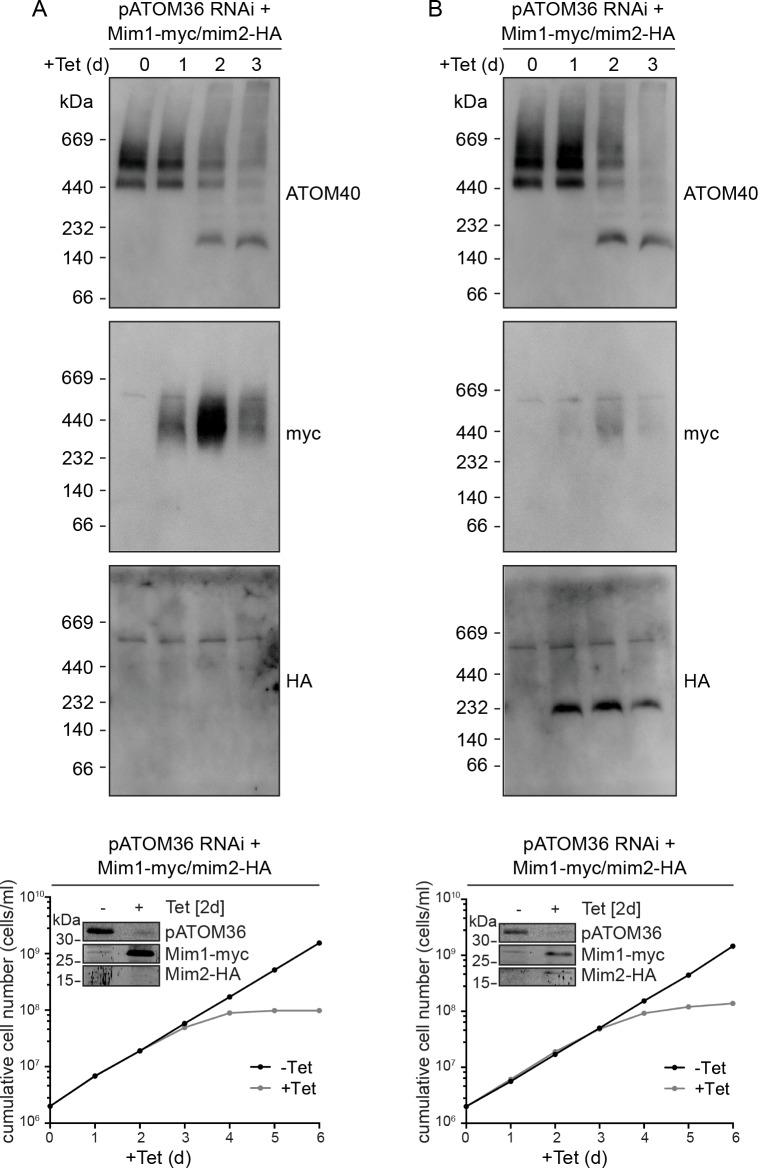
Complementing the biogenesis function of pATOM36 requires both Mim1 and Mim2.Individual clones of a pATOM36-RNAi cell line transfected with plasmids encoding myc-tagged Mim1 and HA-tagged Mim2 were analysed by BN-PAGE and subsequent immunodecoration. Clones that primarily express either myc-tagged Mim1 (A) or HA-tagged Mim2 (B) were analysed. The BN-PAGE blots were probed with anti-ATOM40 (upper panel), anti-myc (middle panel), and anti-HA (bottom panel) antibodies. Days of tetracycline induction (+Tet (d)) are indicated. Bottom graphs: growth curve for the same clone as above analysed in the presence and absence of tetracycline. Days of induction with tetracycline (+Tet [d]) are indicated. Inset: whole cell lysates of the clones were analysed by SDS-PAGE and immunodecoration with the indicated antibodies.